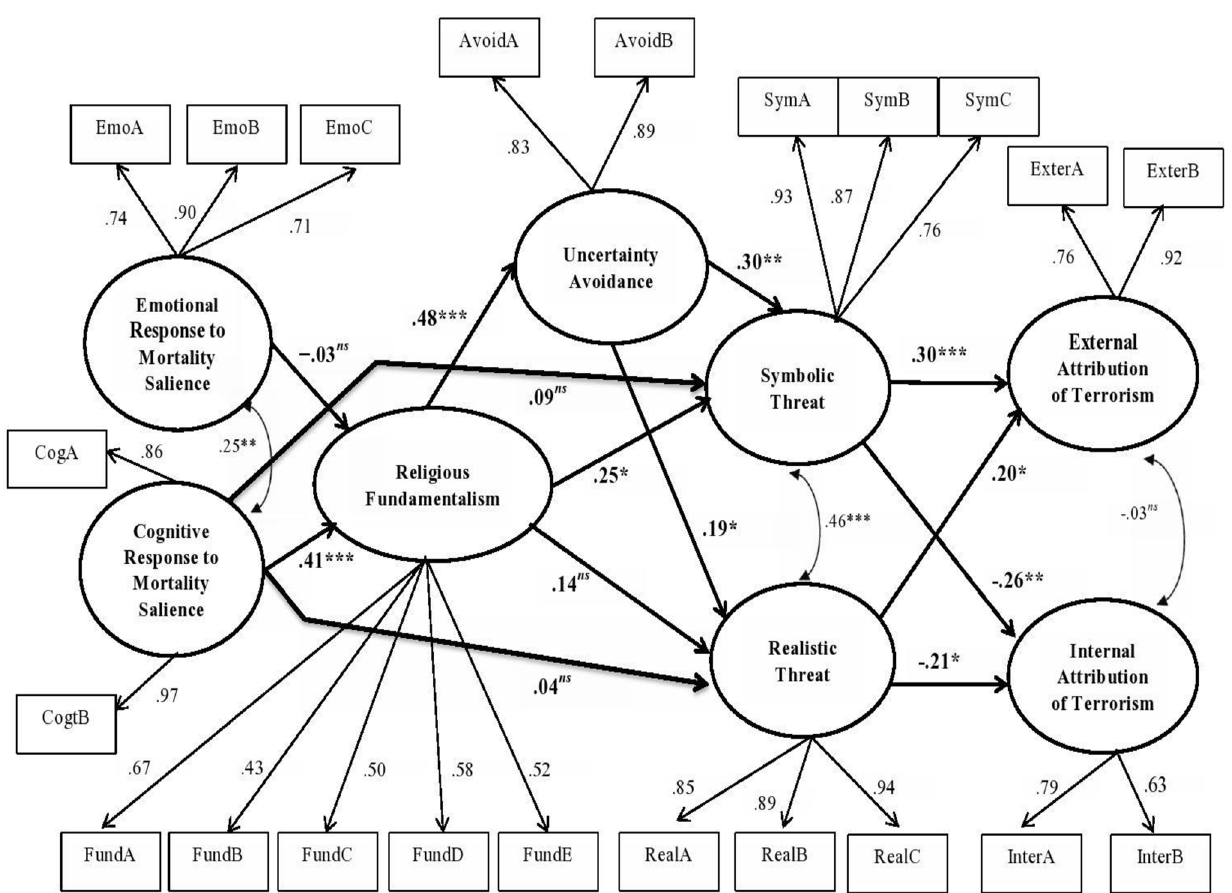
Figure A.4. The Alternative Model 3 in which cognitive response to mortality salience is predicted as not only indirectly affecting symbolic threat and realistic threat via religious fundamentalism but also directly affecting each of these intergroup threats. Note. The numbers were standardized path coefficients and factor-loadings. ExterA−ExterB = External Attribution of Terrorism Parcel A and Parcel B; InterA−InterB = Internal Attribution of Terrorism Parcel A and Parcel B; SymA−SymC = Symbolic Threat Parcel A, parcel B, and Parcel C; RealA−RealC = Realistic Threat Parcel A, parcel B, and Parcel C; AvoidA−AvoidB = Uncertainty Avoidance Parcel A and Parcel B; FundA−FundE = Religious Fundamentalism Parcel A, Parcel B, Parcel C, Parcel D, and Parcel E; EmoA−EmoC = Emotional Response to Mortality Salience Parcel A, Parcel B, and Parcel C. CogA-CogB = Cognitive Response to Mortality Salience Parcel A and Parcel